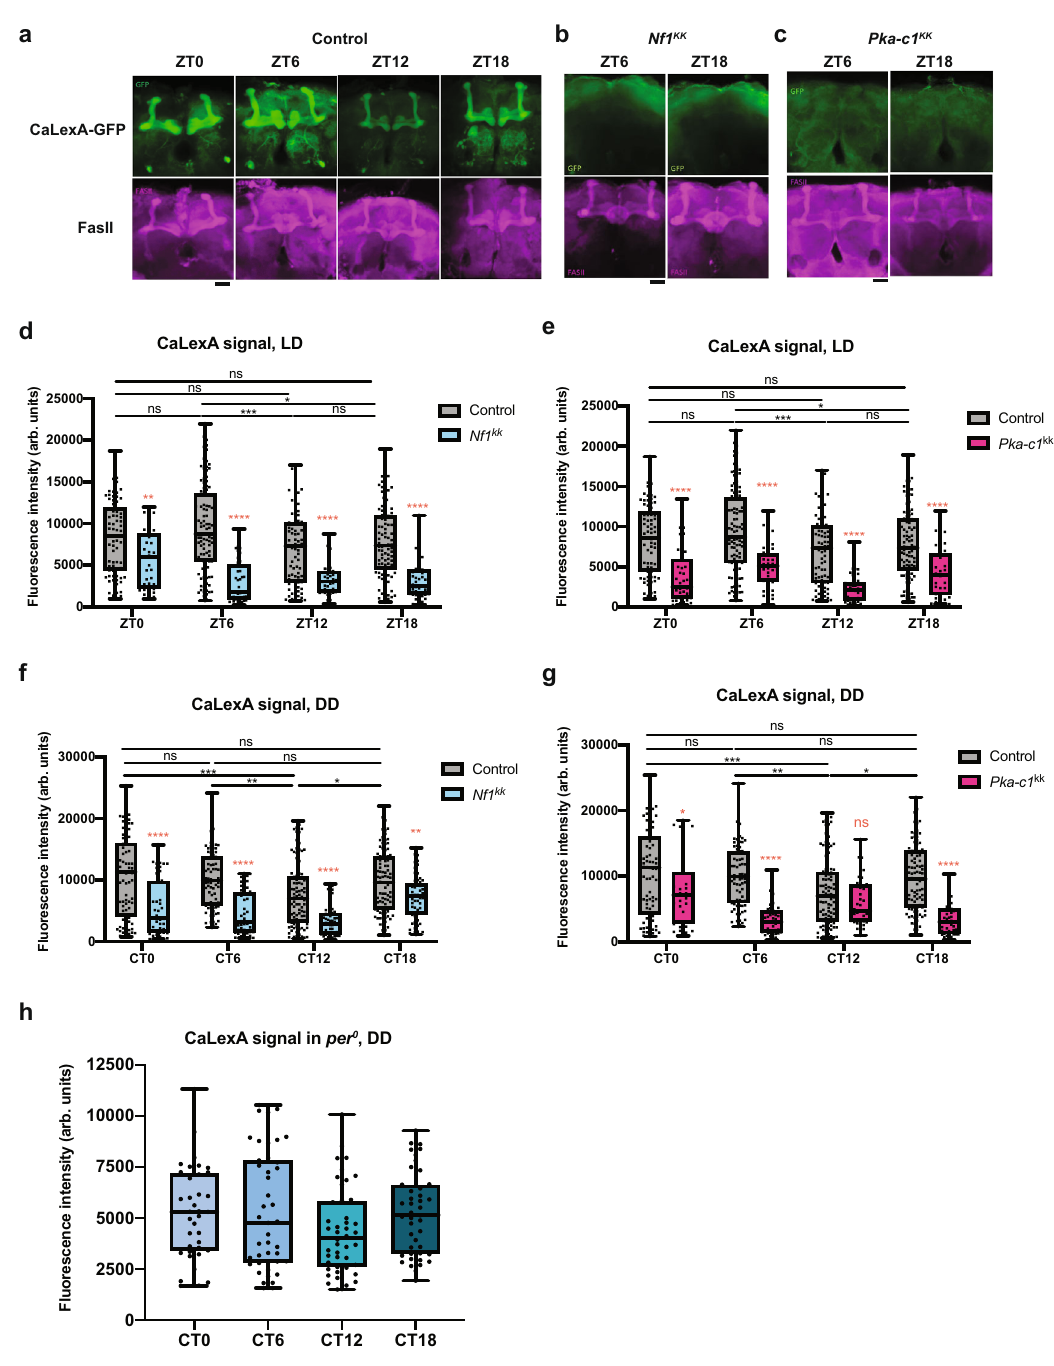
Fig. 8 Circadian clocks control calcium rhythms in MB neurons via NF1 and PKA-C1. Calcium-dependent expression of GFP in the MB lobes was monitored by driving CaLexA-GFP with 30Y-GAL4 , with or without UAS-Nf1 KK or UAS-Pka-C1 KK and co-staining with anti-GFP and anti-Fas II antibodies. a Representative confocal images of CaLexA-GFP expression monitored at four timepoints in LD in the control genotype. Scale bar, 25 μ m. b , c Representative images of the CaLexA-GFP signal with the presence of Nf1 RNAi ( b ) and Pka-C1 RNAi ( c ). Scale bars, 25 μ m. d – g Quanti fi cation of GFP intensity across all MB lobes in LD with or without Nf1 RNAi ( d ), in LD with or without Pka-C1 RNAi ( e ), in DD with or without Nf1 RNAi ( f ), and in DD with or without Pka-C1 RNAi ( g ). n = 45 – 60. arb. units arbitrary units. The center lines of the boxplots indicate the median and the whiskers represent the minimum and maximum values. Black stars indicate statistical signi fi cance levels comparing values within the control group between timepoints using the nonparametric Kruskal – Wallis one-way ANOVA with Dunn ’ s multiple comparisons test (* p < 0.05, ** p < 0.01, and *** p < 0.001). Red stars indicate the statistical signi fi cance levels comparing the control and knockdown groups at the same timepoint. (** p < 0.01, *** p < 0.001, and **** p < 0.0001, two-way ANOVA with Sidak ’ s multiple comparisons test). Statistical test results comparing values between timepoints within the knockdown group are displayed in Fig. S5. h Quanti fi cation of GFP intensity across all MB lobes in DD in per 0 . The boxplots are as in d – g . n = 40 – 45. The Kruskal – Wallis one-way ANOVA with Dunn ’ s multiple comparison ’ s test found no signi fi cant difference between timepoints. GFP levels in per 0 were signi fi cantly lower than those in controls (displayed in f and g ) in DD across all timepoints (**** p < 0.0001 at CT0, 6, and 18, (** p < 0.01 at CT12, with the Kruskal – Wallis one-way ANOVA followed by Dunn ’ s multiple comparisons test). Source data are provided as a Source Data fi